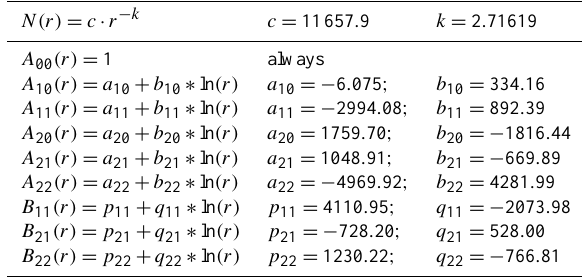
Table 5. Equinox model fit